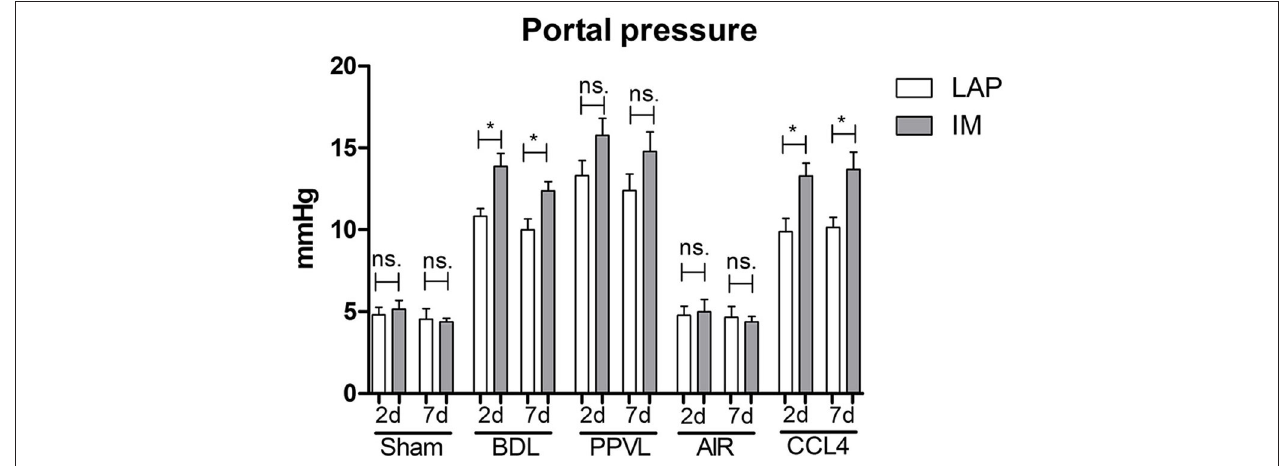
FIGURE 3 | In-vivo portal pressure development 2 or 7 days after IM vs. LAP in the different animal models (BDL and PPVL vs. Sham and CCL4 vs. AIR), showing significantly elevated portal pressure after IM in all BDL and CCL4 groups. * p ≤ 0.05; ns. (p >